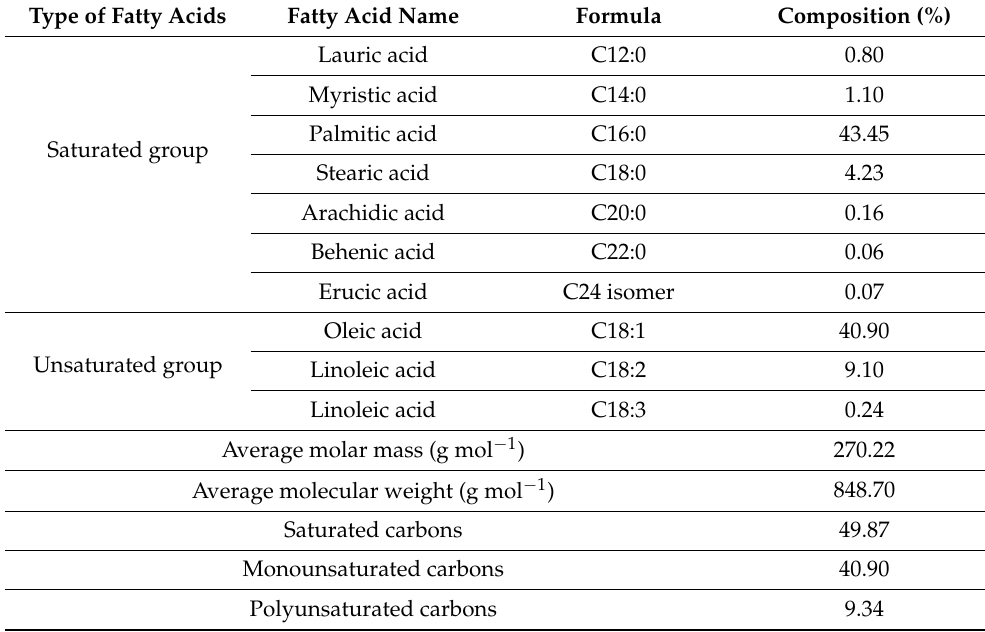
Table 1. Fatty acid composition of refined palm oil